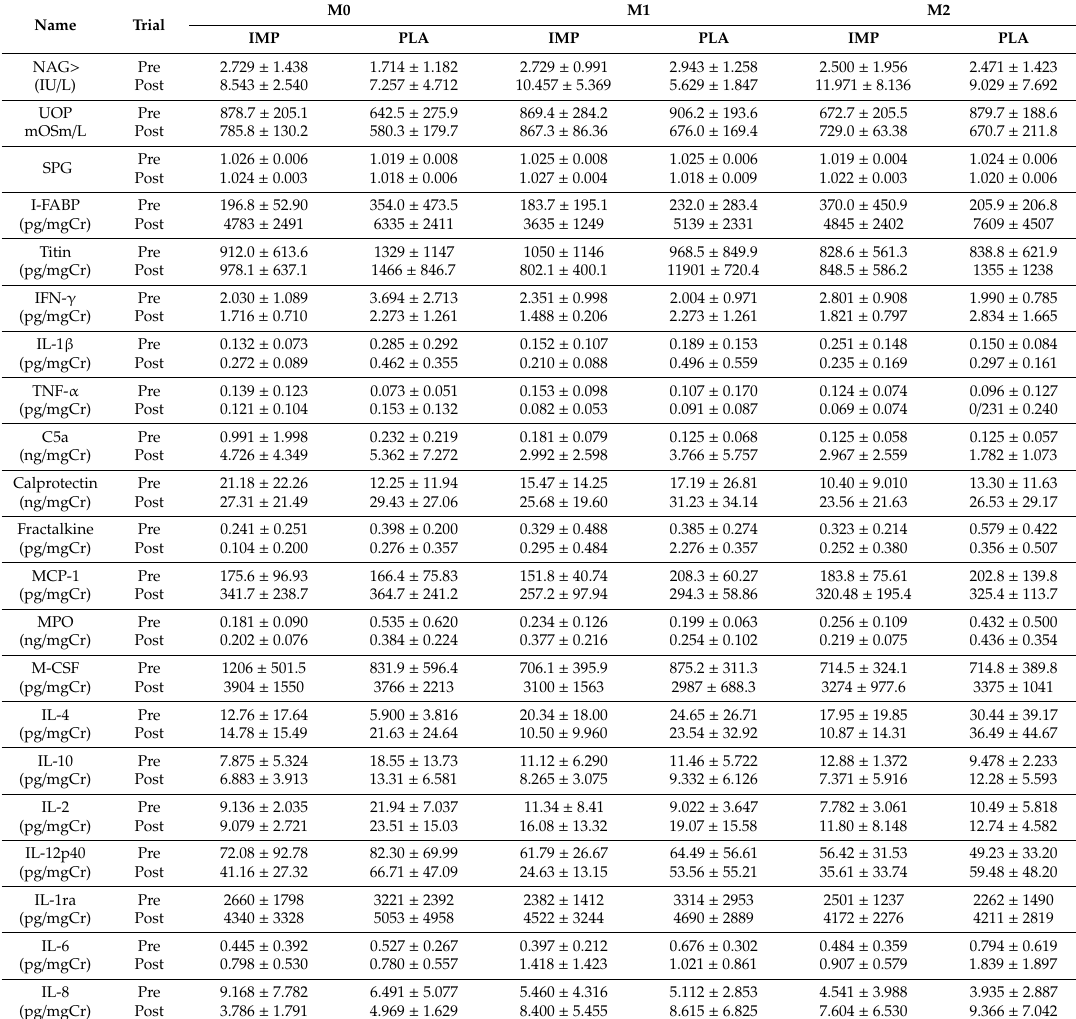
Table 1. Summary of data from Figures